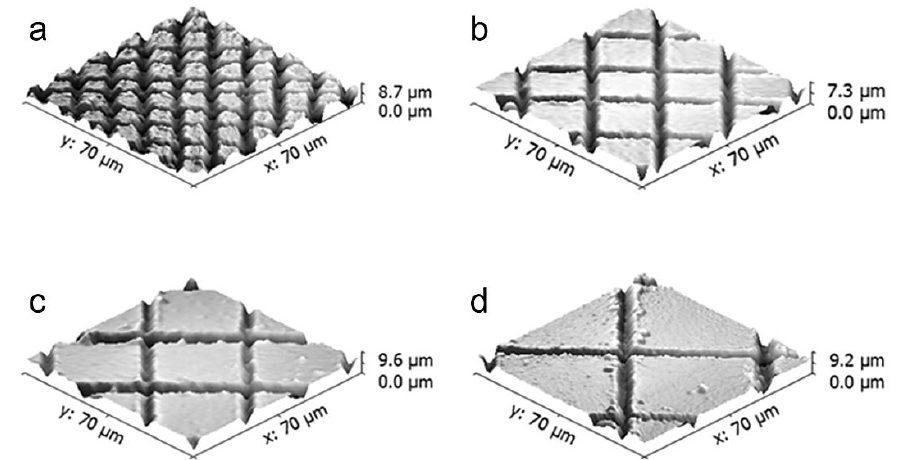
Figure 8. Atomic force microscopy (AFM) images of nano/microstructured polydimethylsiloxane (PDMS) films with periodicities of 10 µ m ( a ), 20 µ m ( b ), 30 µ m ( c ) and 40 µ m ( d ). Reprinted with (PDMS) films with periodicities of 10 µm ( a ), 20 µm ( b ), 30 µm ( c ) and 40 µm ( d ). Reprinted with permission from [92], Copyright (2015), Wiley Online permission from [92], Copyright (2015), Wiley Online Library.